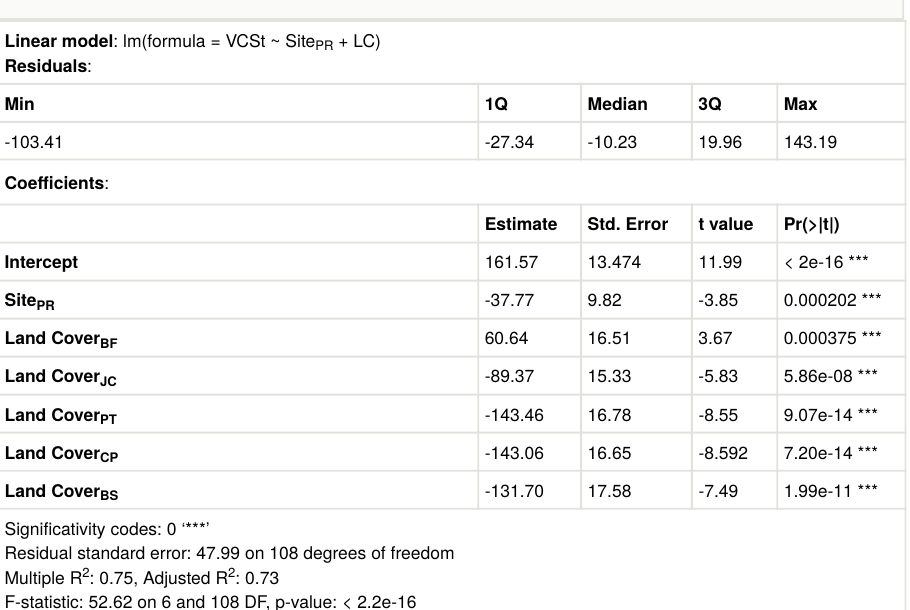
Table 2. Outputs of the fi nal linear model. Acronyms: Site : Palmares II and Land Cover : class n of Land PR Cover (F: Forest; BF: Burned Forest; JC: Jucuira-Capoeira-Fallow lands; PL: Pasture with tree; CP: Clean Pasture and BS: Bare Soil). Linear model : lm(formula = VCSt ~ Site + LC)